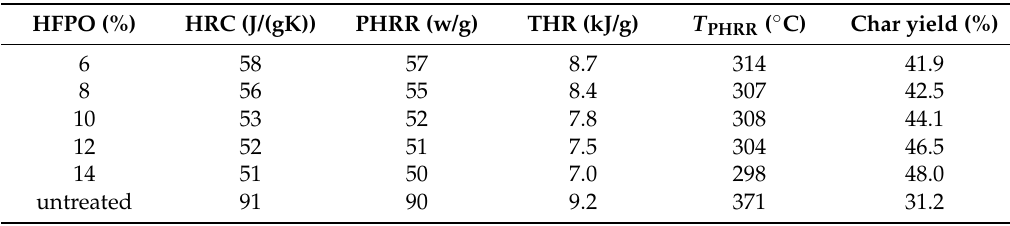
Table 4. The heat release properties and char yield of the Nomex ® /cotton blend fabric treated with 3% BTCA and HFPO at different concentration, cured at 170 °C for 3 min and finally subjected to one home laundering cycle.